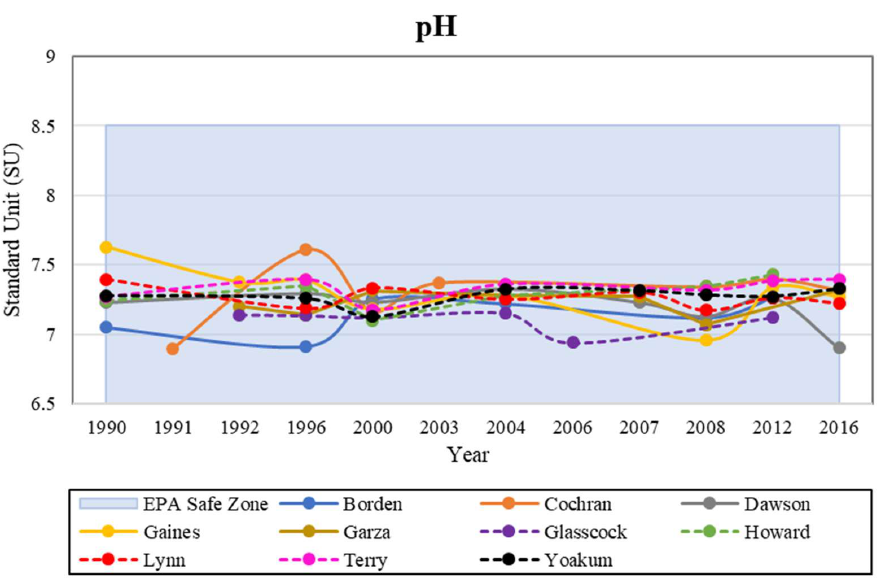
Figure 7. Historical analysis of pH levels in the study area, within the EPA safe zone.